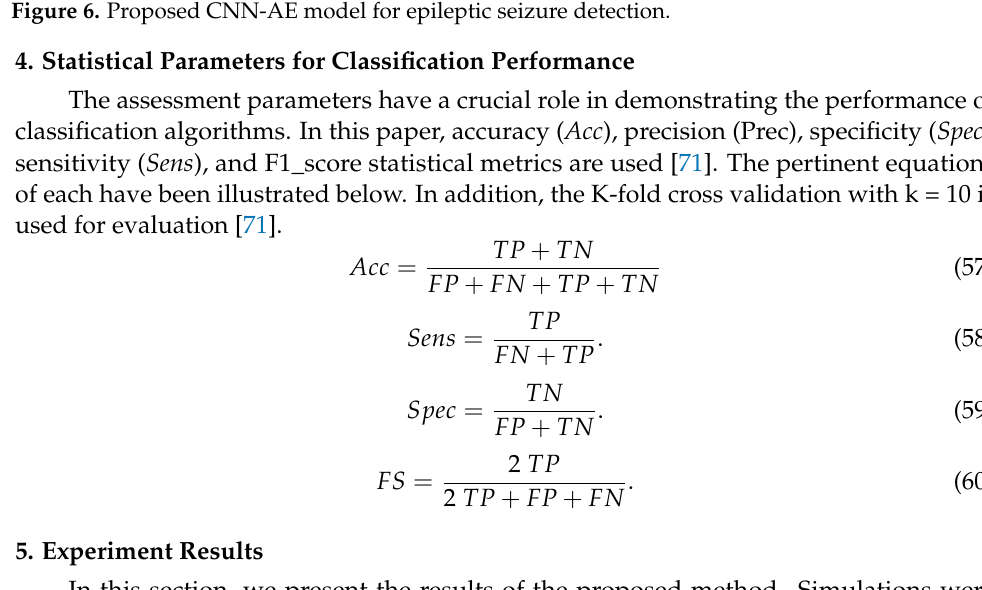
Figure 6. Proposed CNN-AE model for epileptic seizure detection.